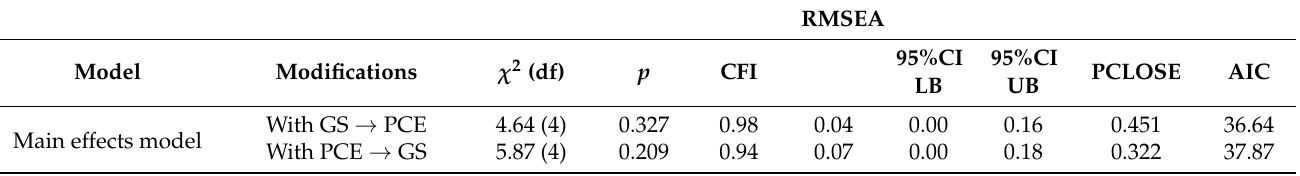
Table 5. Fit indices alternative